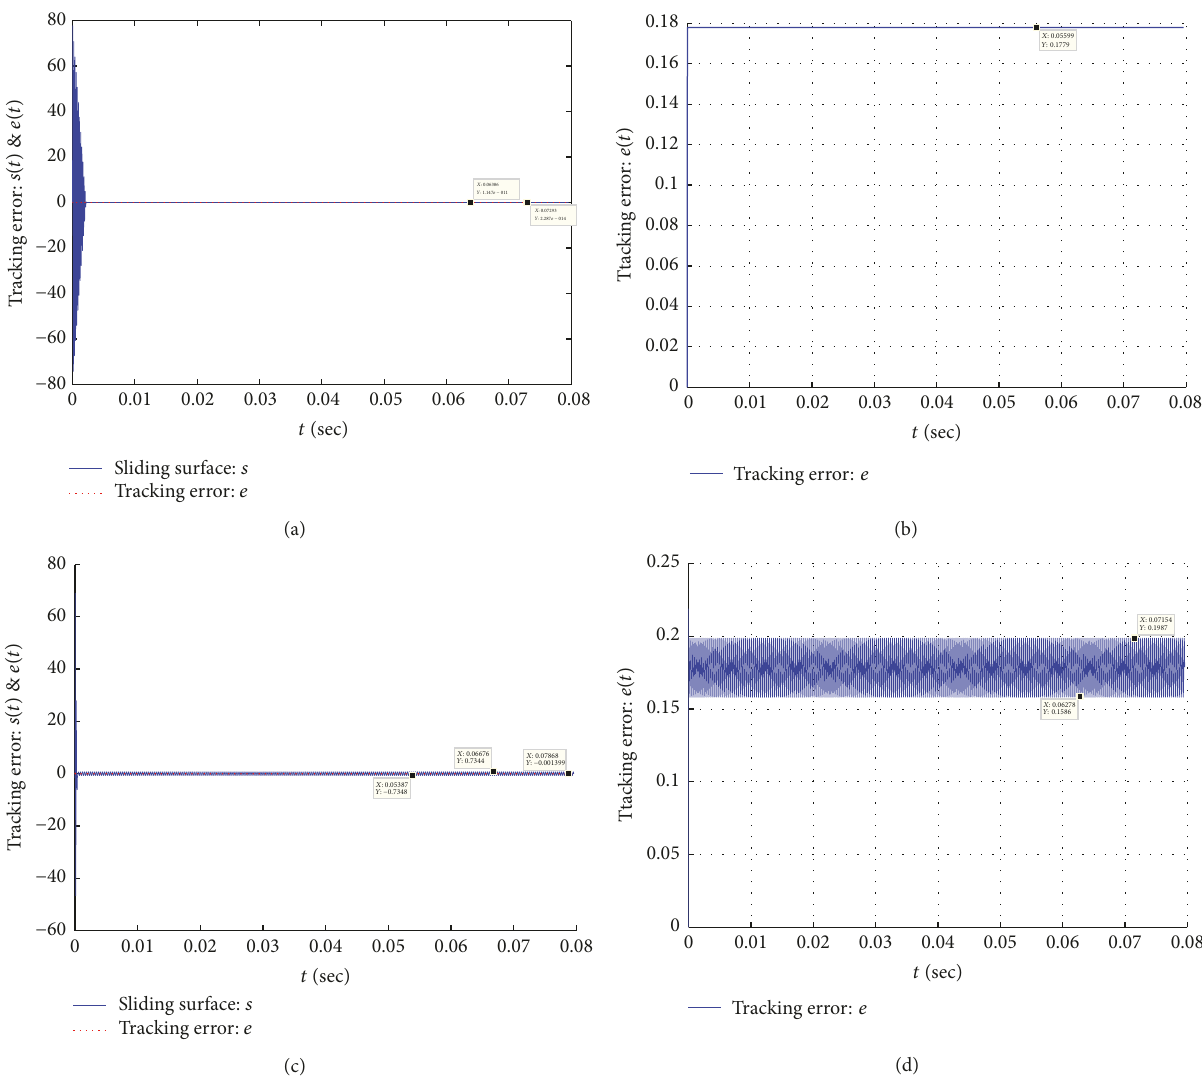
Figure 4: Tracking performance comparison between adaptive sliding mode controller and pole-placement state feedback one, both being susceptible to various malfunctioning effects: (a) tracking performance of adaptive sliding mode controller considering 10 % divergence of the real values of stiffness and damping factors from the nominal ones; (b) tracking performance of pole-placement state feedback controller considering 10 % divergence of the real values of stiffness and damping factors from the nominal ones; (c) tracking performance in adaptive sliding mode controller when it is susceptible to parameter uncertainty and variation; (d) tracking performance of pole-placement state feedback controller being susceptible to parameter uncertainty and